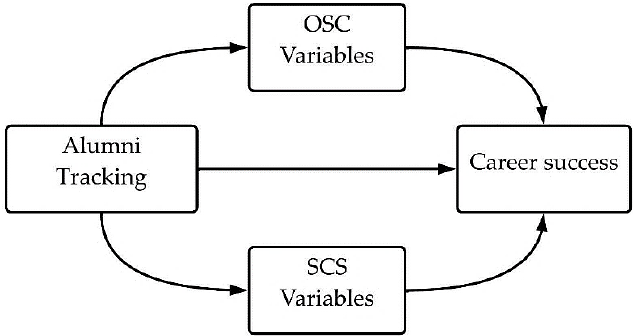
Figure 4. Relationship between alumni tracking and career success.